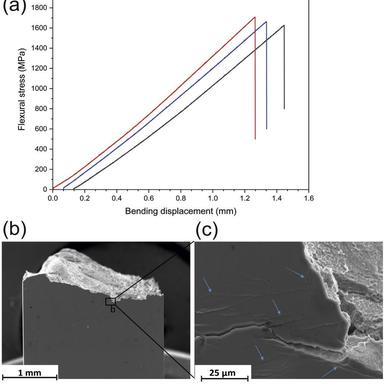
(a) Stress-displacement curves from three-point bending tests. (b) Macroscopic side-view image of a sample after failure. (c) Higher-magnification image of the area marked in (b), showing shear bands (marked by blue arrows).